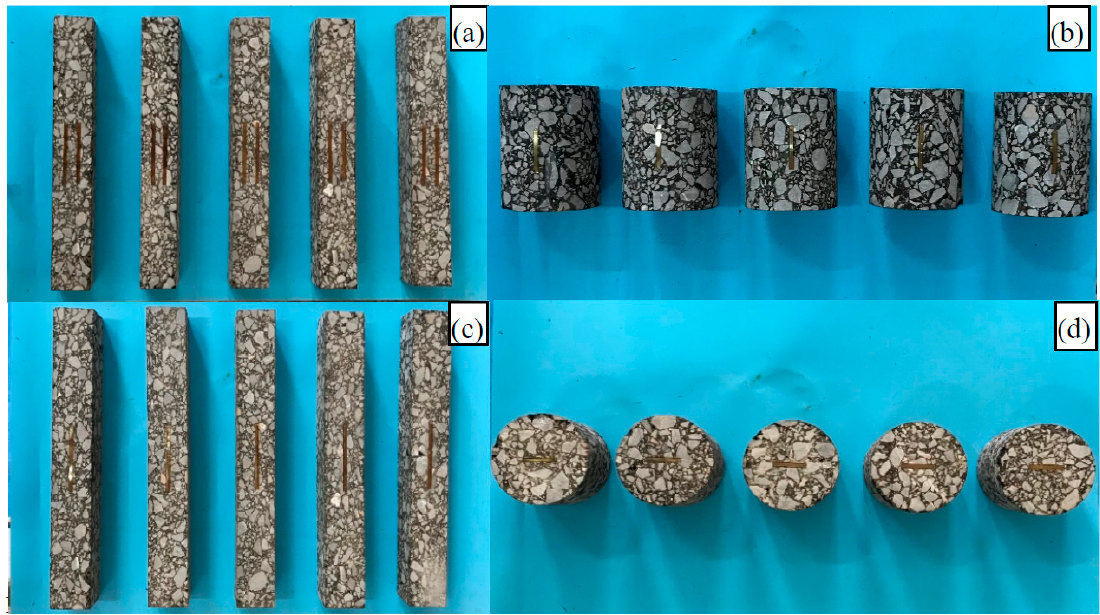
Figure 2. Samples for various tests for the: ( a ) four-point bending moduli test, ( b ) indirect tensile moduli test, ( c ) direct tensile moduli test, ( d ) unconfined compressive moduli test.